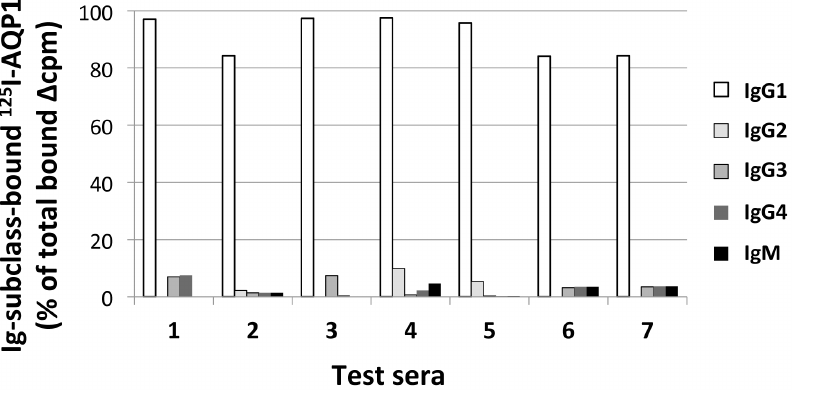
Figure 7. Ig class and IgG subclass of the anti-AQP1 antibodies. The Ig class and IgG subclass of the anti-AQP1 antibodies from 7 positive human sera was tested by RIPA using anti-class/subclass second antibodies. Sera no. 1-4 are from patients 11-14 in Table 1 and sera no. 5-7 are from the remaining anti-AQP1 antibody-positive sera.